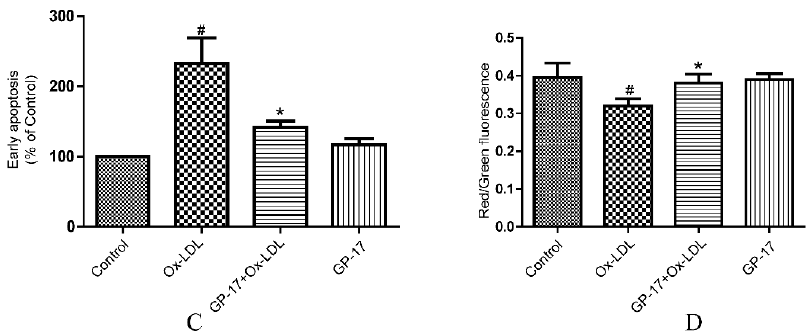
Figure 6. GP-17 protected against Ox-LDL-induced apoptosis in HUVECs. ( A ) Apoptosis in HUVECs was analyzed by flow cytometry; ( B ) ΔΨ m was assessed by fluorescence microscopy; ( C ) Quantitative analysis of the percentages of early apoptotic cells; ( D ) Quantitative analysis of ΔΨ m by plate reader. The values are expressed as the mean ± S.E.M. from three independent experiments. # p < 0.05 vs. Control; * p < 0.05 vs. Ox-LDL. PI, propidium iodide.